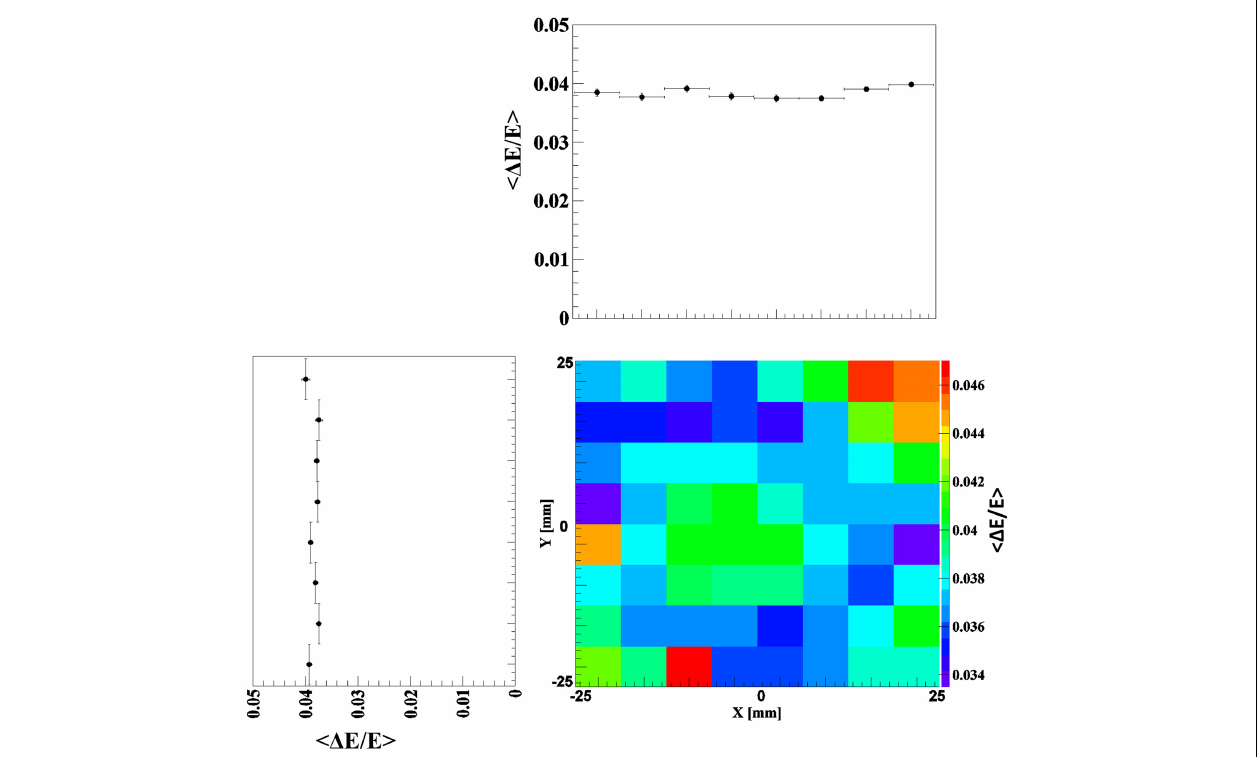
FIGURE 3 | 2D energy resolution map measured by scanning the reflectively coated LaBr 3 :Ce crystal with a 1-mm collimated 137 Cs source and step a size of 6mm in x and y direction . The x and y projections (averaged over the complementary direction) show an almost position independent energy resolution of 3.8% on average.